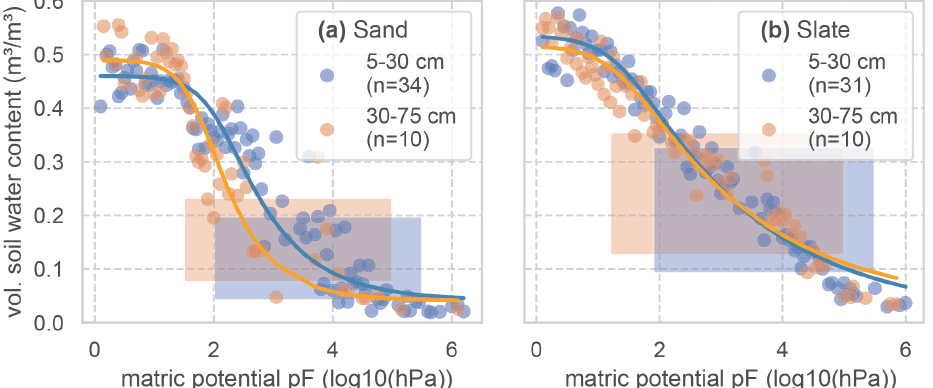
Figure C1. Soil water retention curves for two soil layers at both experimental sites. To derive the retention curves, the matric potential is divided into bins of 0.05pF. Measured soil moisture values of all samples and at tensions that fall into each bin are averaged and displayed as dots. The retention curve is fitted to these points. The resulting van Genuchten parameters are given in Table C1. The number of soil samples that form the basis for the retention curves is given as n . The shaded areas mark the range of soil moisture values we observed with the TDR probes in this study.